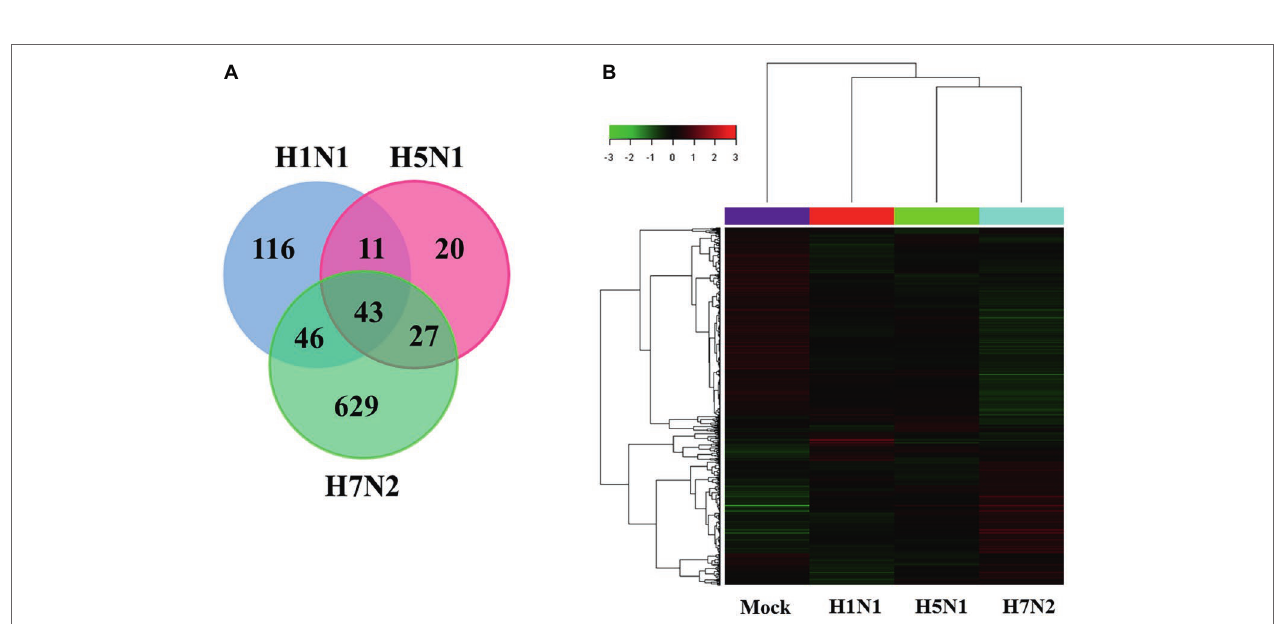
FIGURE 2 | Identification and quantification comparison of differentially abundant genes in P815 cells infected with different subtypes of IAV. (A) Venn diagrams showing the overlap of DEGs in P815 cells infected with three subtypes of IAV, respectively. (B) Heat map presenting the screened